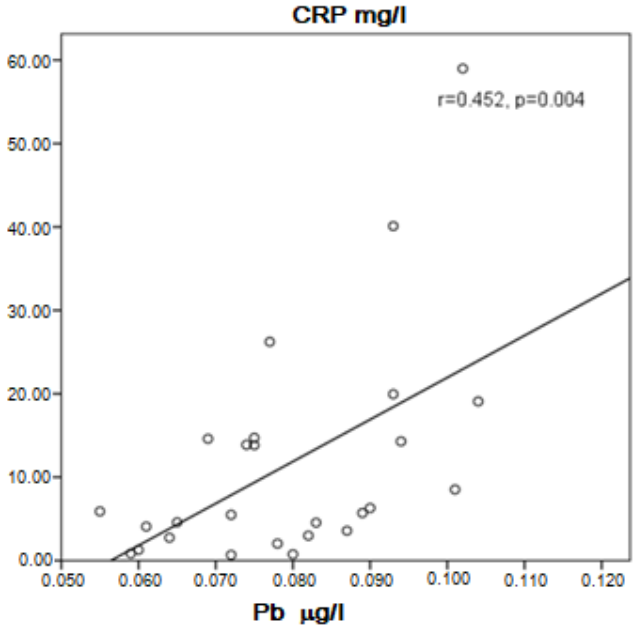
Figure 2. Correlation of Pb and CRP in COPD patients.